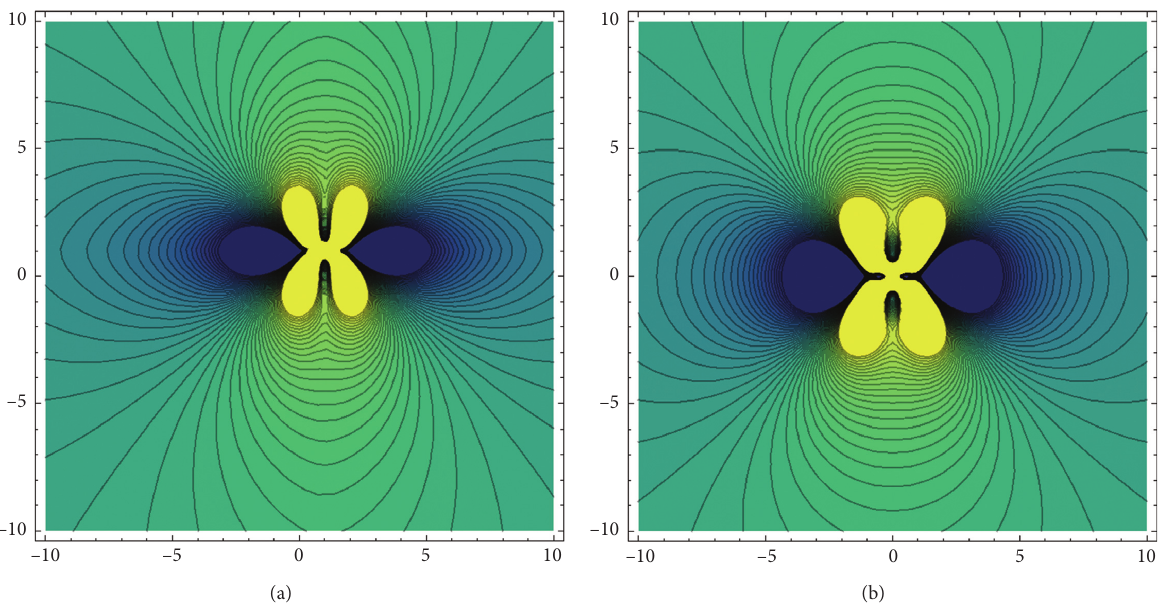
Figure 7: Contours of first-order fractional rogue wave solution (color online) (39) and its comparison with the integer order. (a) α � 9/7 and a � 1; (b) α � 1 and a �